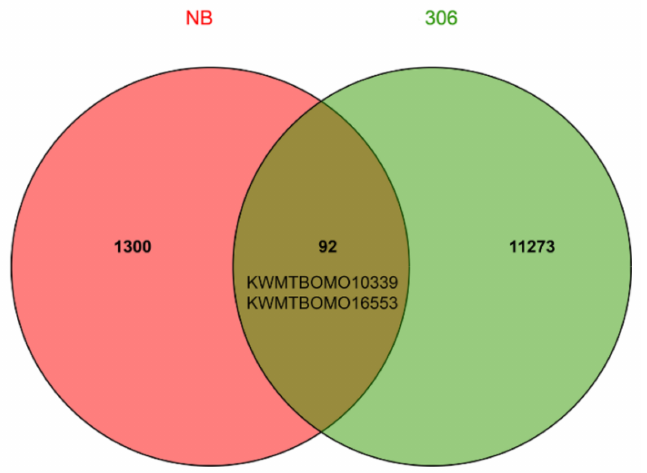
Figure 4. Venn analysis of DEGs between yellow cocoon silkworm strain NB and white cocoon silkworm strain 306. Among them, the expression of DEGs in the NB group was 0, while the expression of DEGs in the 306 groups was more than